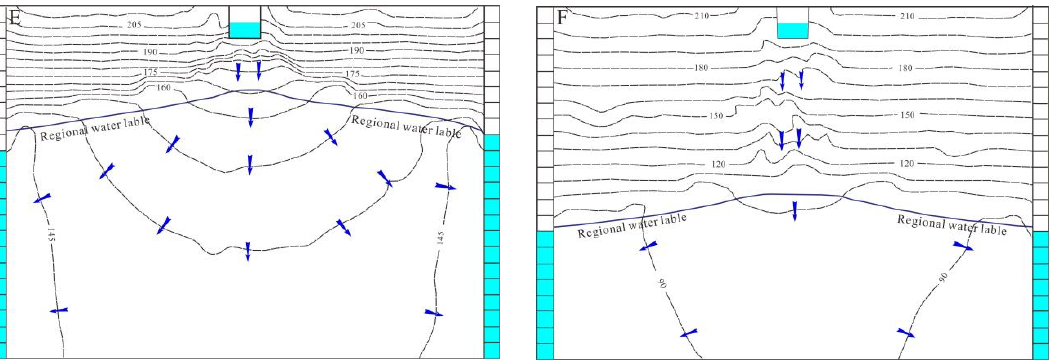
Figure 7. The change in the relationship between river water and groundwater in the sandbox experiment under the water-bearing medium sand B and a river water depth of 10 cm. Discharge water level ( A ): 200 cm, ( B ): 170 cm, ( C ): 160 cm, ( D ): 150 cm, ( E ): 140 cm, and ( F ): 80 cm.